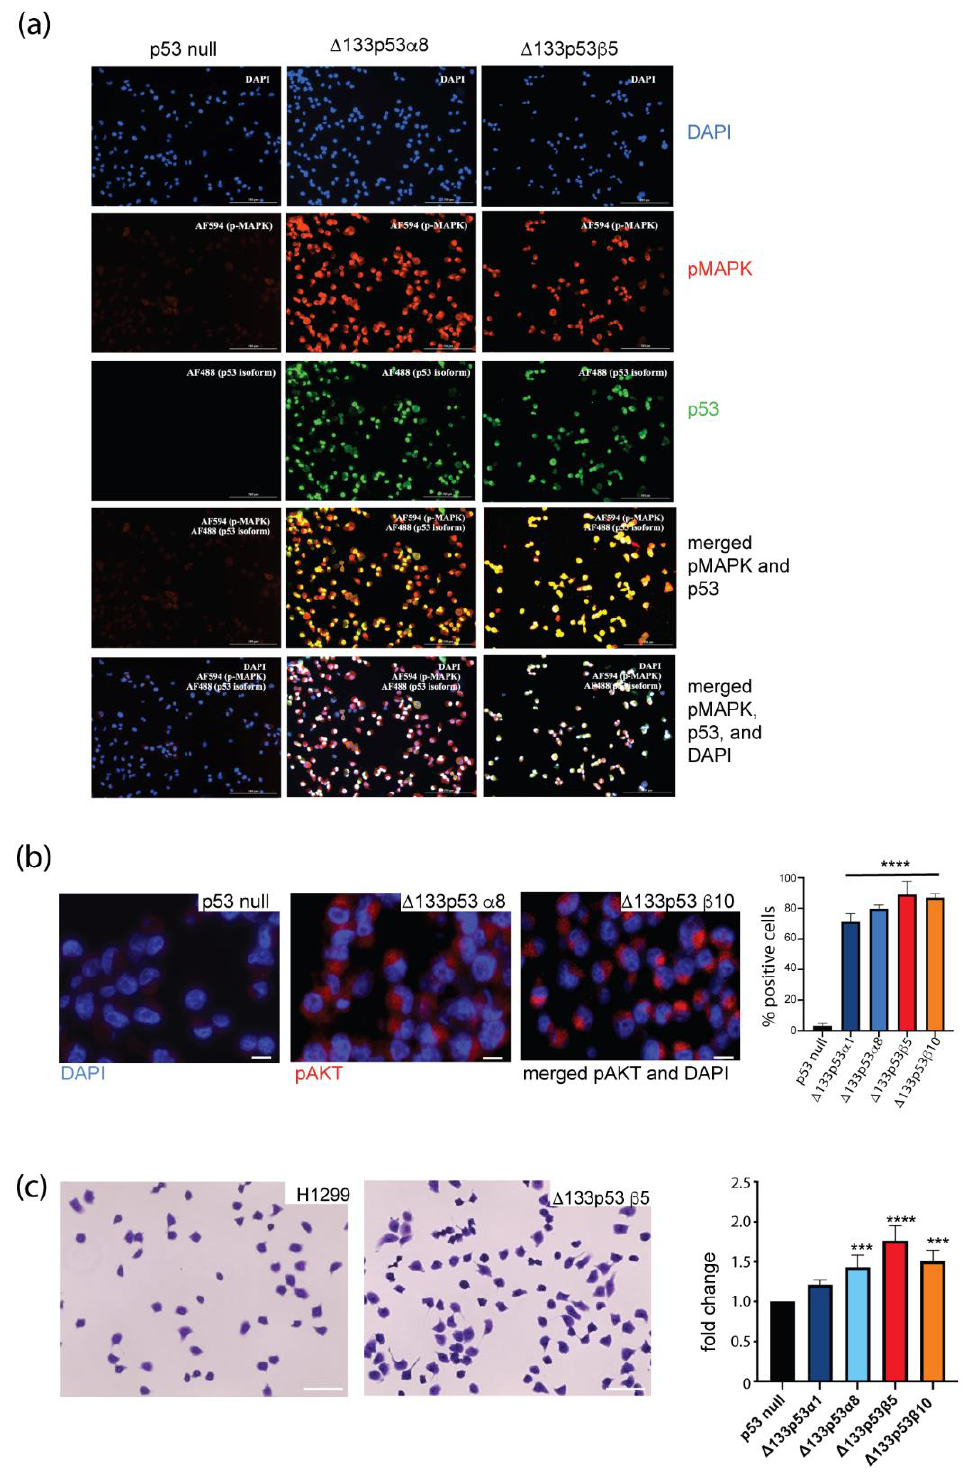
Figure 6. Cancer-promoting pathways increased with Δ 133p53 α and Δ 133p53 β . ( a ) Increased p-MAPK (scale bar 200 µm) and ( b ) p-AKT (scale bar 25 µm) were evident when using immunofluorescence in Δ 133p53 α and Δ 133p53 β cells. ( c ) Δ 133p53-expressing cells were more likely to move through an in vitro blood – brain barrier. Crystal violet staining (left, scale bar 100 µm) and quantification (right) of cells that moved through the barrier. Results: mean ± s.d. from at least three replicates. * p < 0.05, ** p < 0.01, *** p < 0.001, **** p < 0.0001.